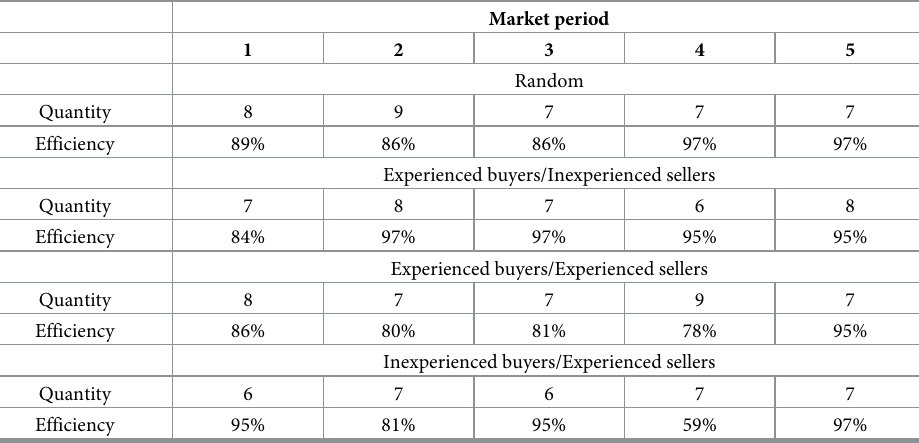
Table 3. Sample statistics from